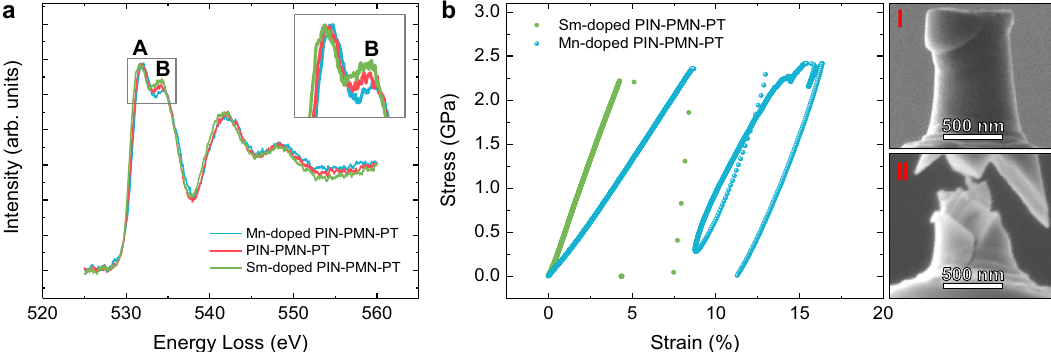
Fig. 4 Analysis of the origin of excellent plasticity. a O-EELS obtained from Mn- (blue), Sm- (green) doped and undoped (red) PIN-PMN-PT. The enlarged image (inset) shows the intensity difference of peak B for Mn-, Sm- doped and undoped PIN-PMN-PT, where a lower intensity suggests a higher V (cid:2)(cid:2) O concentration. b Engineering stress ‒ strain curves obtained from in-situ compression tests of Mn- (blue sphere) and Sm- (green circle) doped PIN-PMN-PT. Images I and II show SEM images of the compressed Mn-doped and Sm-doped PIN-PMN-PT